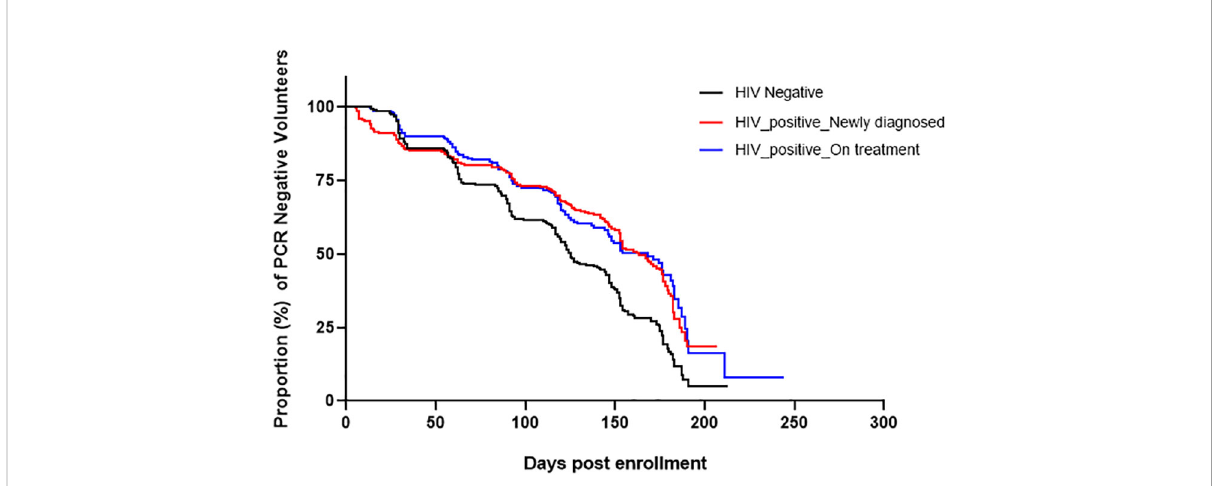
FIGURE 3 Kaplan-Meier curves showing time to infection post-enrollment. Only volunteers who were negative by 18S PCR at enrollment were included in this analysis. The median time to infection for HIV-1 negative volunteers was signi fi cantly shorter 149 days, (Log-rank Mantel-Cox test; c 2 (2) = 7.3, p =0.00136) while that of HIV-1 positive newly diagnosed and HIV-1 positive on treatment were 171 and 177 days,